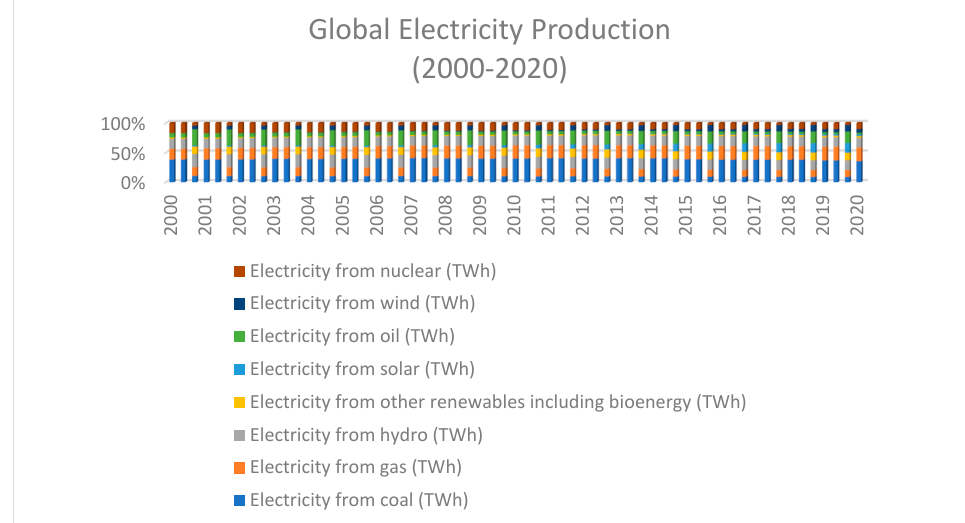
Figure 4. Global Electricity Production (2000–2020). Constructed by the authors.